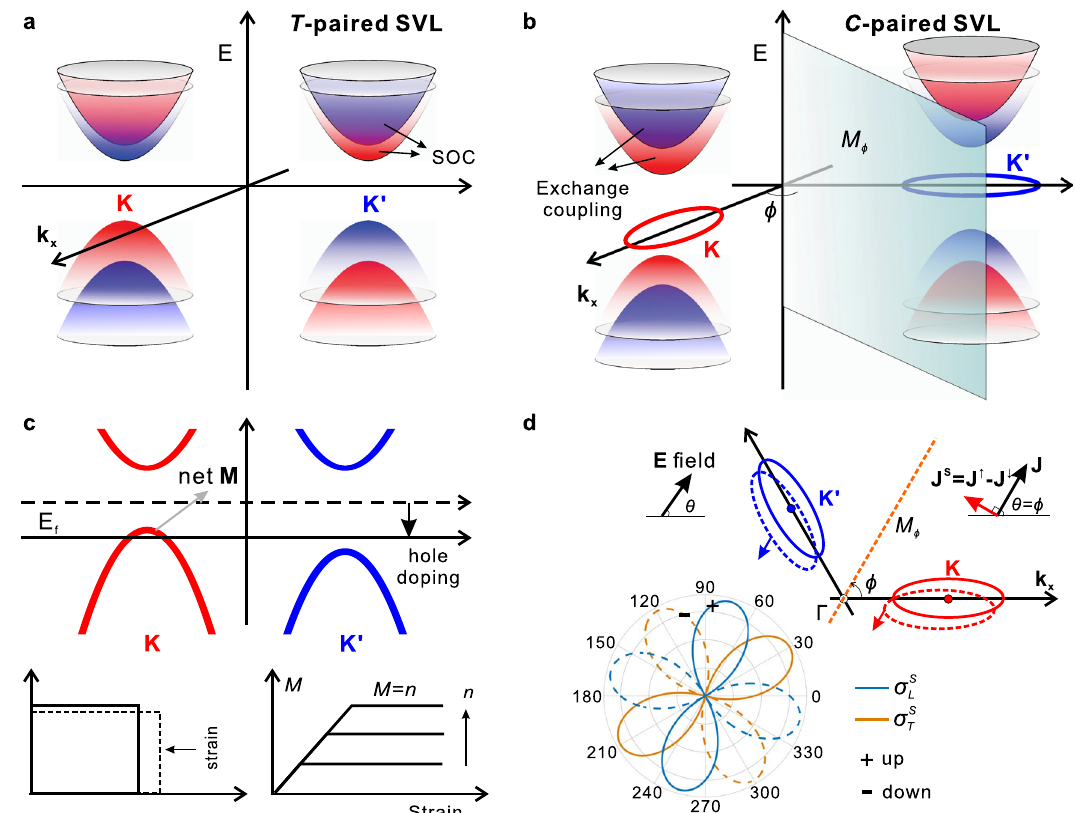
Fig. 1 Schematics of C-paired spin-valley locking (SVL) and its properties. a In T- paired SVL, the splitting between spin-up (red) and spin-down (blue) bands is from strong spin-orbit coupling (SOC) when inversion symmetry is broken, and the two valleys are related by the time-reversal ( T ) symmetry. b However, for C- paired SVL, the spin splitting is owing to exchange couplings between itinerant electrons and local magnetic moments, and different valleys are related by a crystal symmetry (a mirror symmetry M ϕ as an example). c A strong valley polarization can be easily induced by a strain, and the piezomagnetism will simultaneously happen upon fi nite doping. M fi rst increase linearly with the strain and fi nally gets saturated for large strain with M equal to n . d Contribution to the charge current from different valleys are in general different, which gives rise to a non-zero spin current J S ¼ J K (cid:2) J K 0 . One typical result ( ϕ ¼ π ) is in the bottom panel. Both longitudinal and transverse spin currents depend on the electric fi eld E direction θ with a period of π . 6 When θ ¼ ϕ or ϕ þ π , where E does not break the mirror symmetry, the longitudinal charge currents from different valleys are the same, whereas transverse charge currents are exactly opposite, which result in pure spin currents perpendicular to the charge currents, i.e., spin Hall